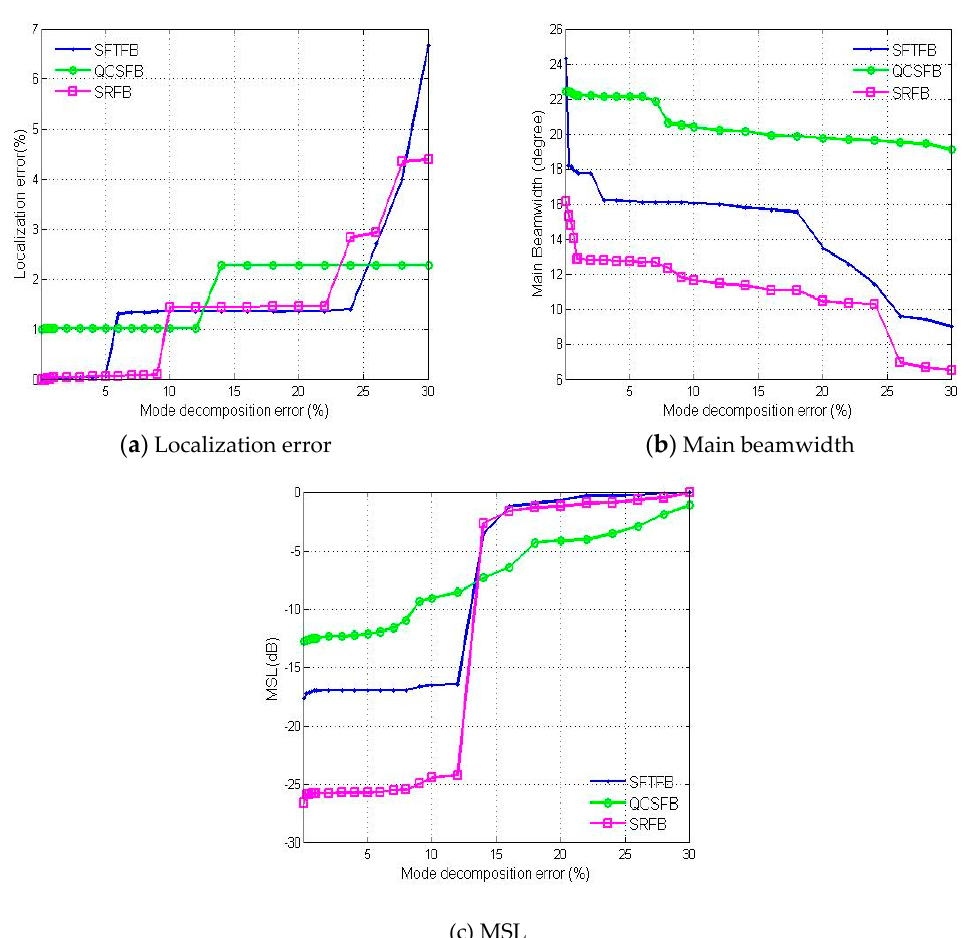
Figure 8. The performance of the three methods investigated based on the ( a ) localization error, ( b ) main beamwidth and ( c ) MSL with respect to the mode decomposition error.